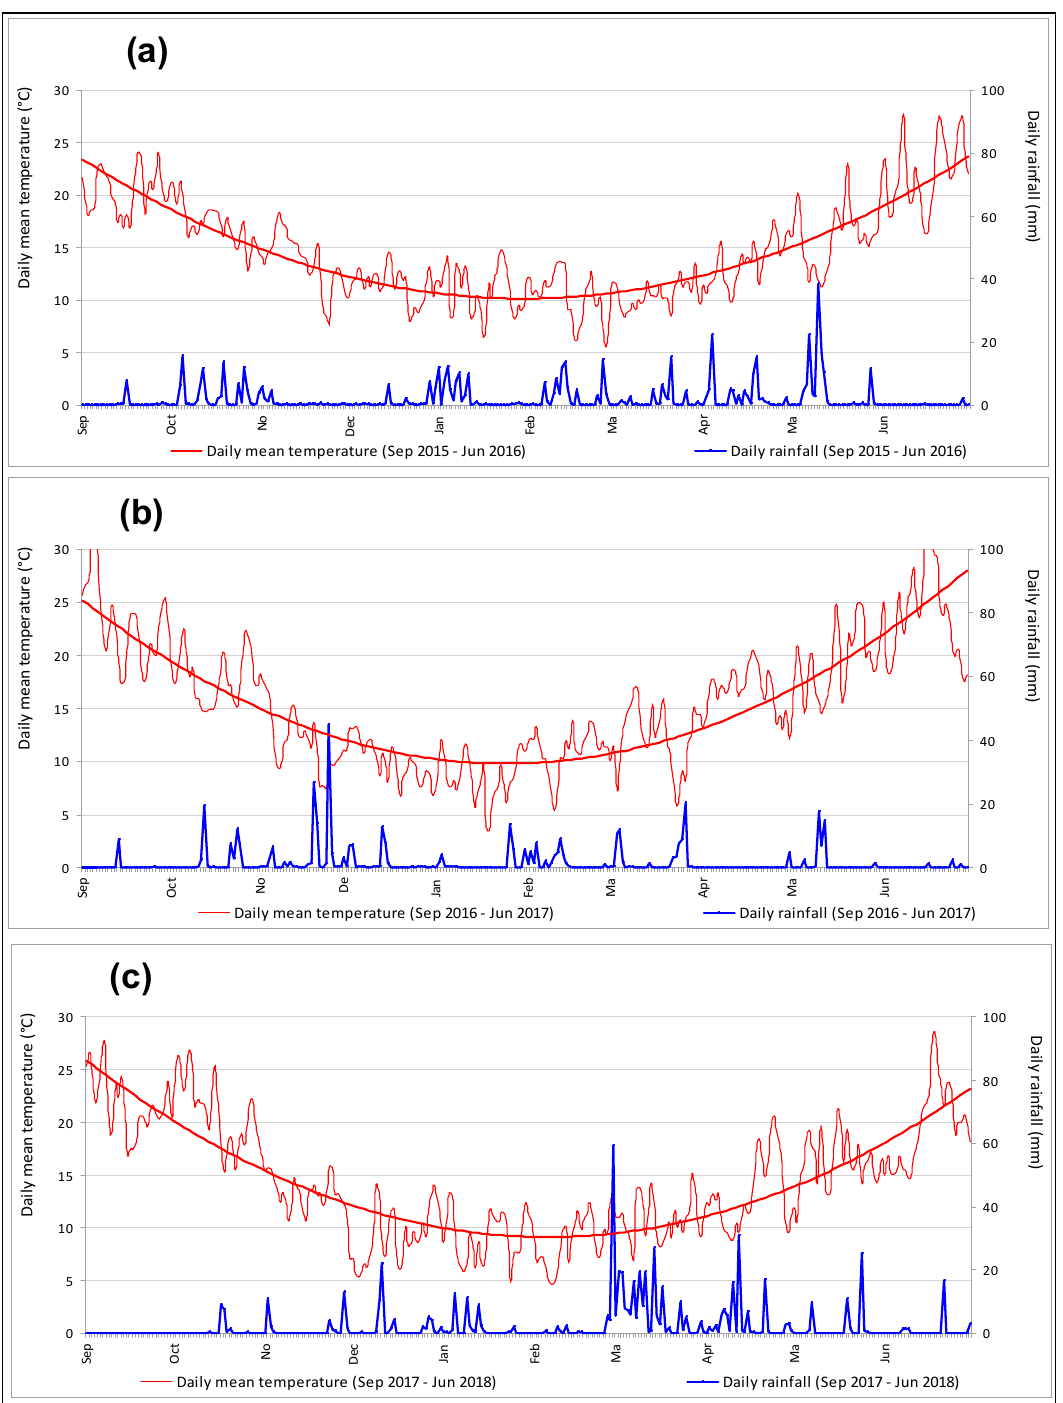
Figure 3. Thermo-pluviometric diagrams of the “Mitra” meteorological station: ( a ) September